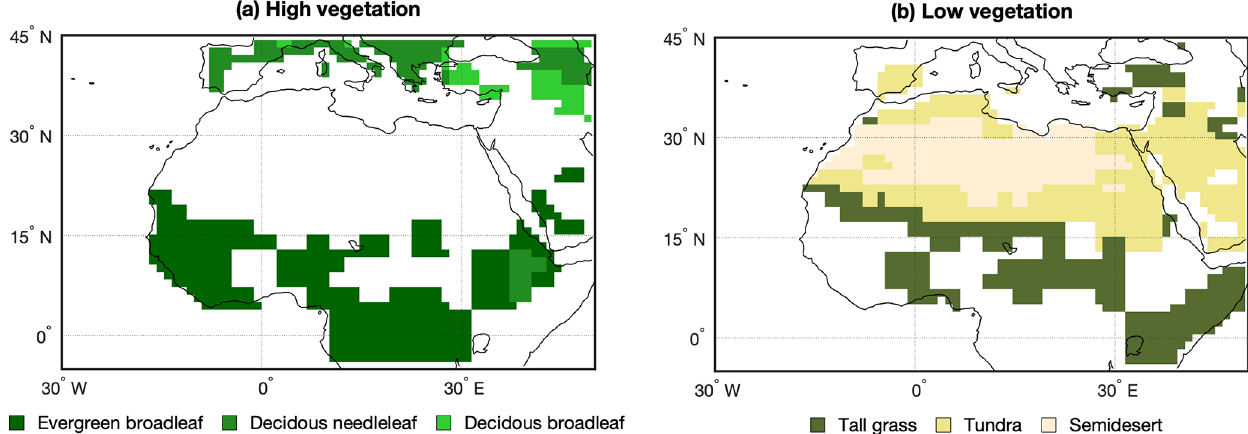
Figure 8. Prescribed PRISM4 (a) high and (b) low vegetation used as boundary conditions for PlioMIP2 simulations (Dowsett et al., 2016), sourced from Salzmann et al.